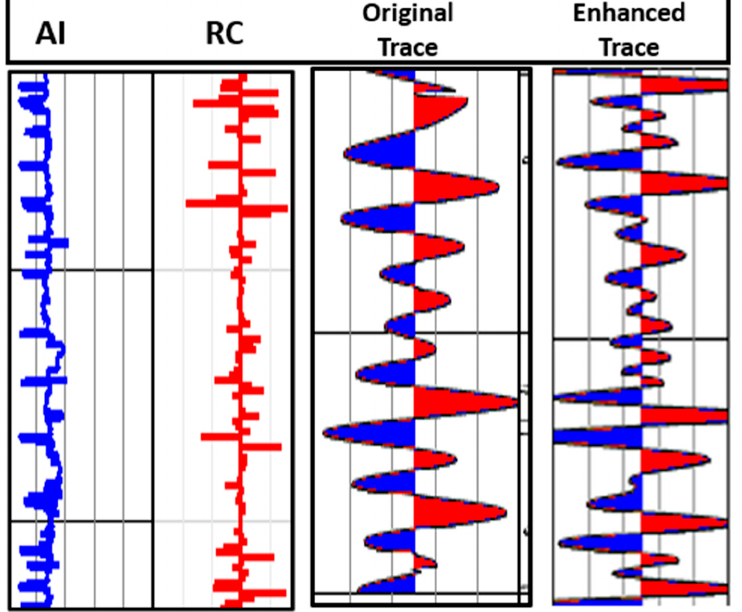
Figure 16. Comparison of the seismic traces (original and enhanced) with the reflectivity (RC) series from well data.